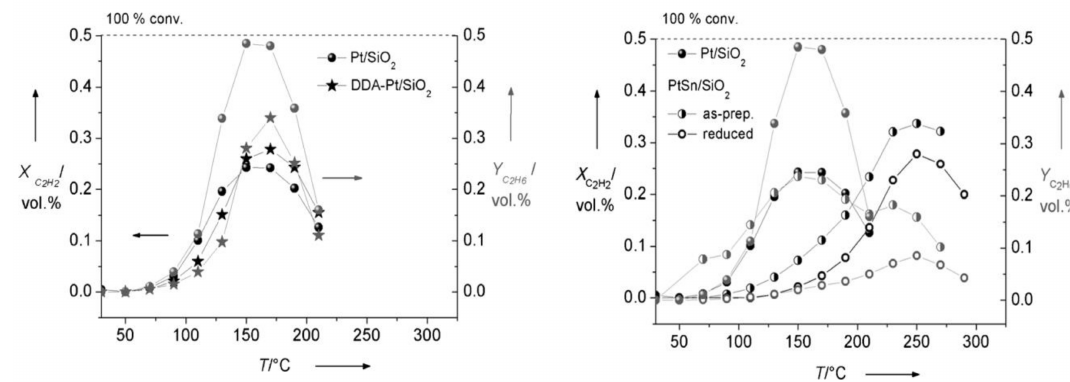
Figure 26. Acetylene conversion X (black symbols, left axis) and ethane time yield Y (gray symbols, right axis) as functions of temperature for: Left monometallic Pt/SiO 2 (circles) and DDA-Pt/SiO 2 (stars) catalysts. Right Pt/SiO 2 (filled symbols), Pt/Sn(1:1)/SiO 2 as prepared (half-filled symbols),